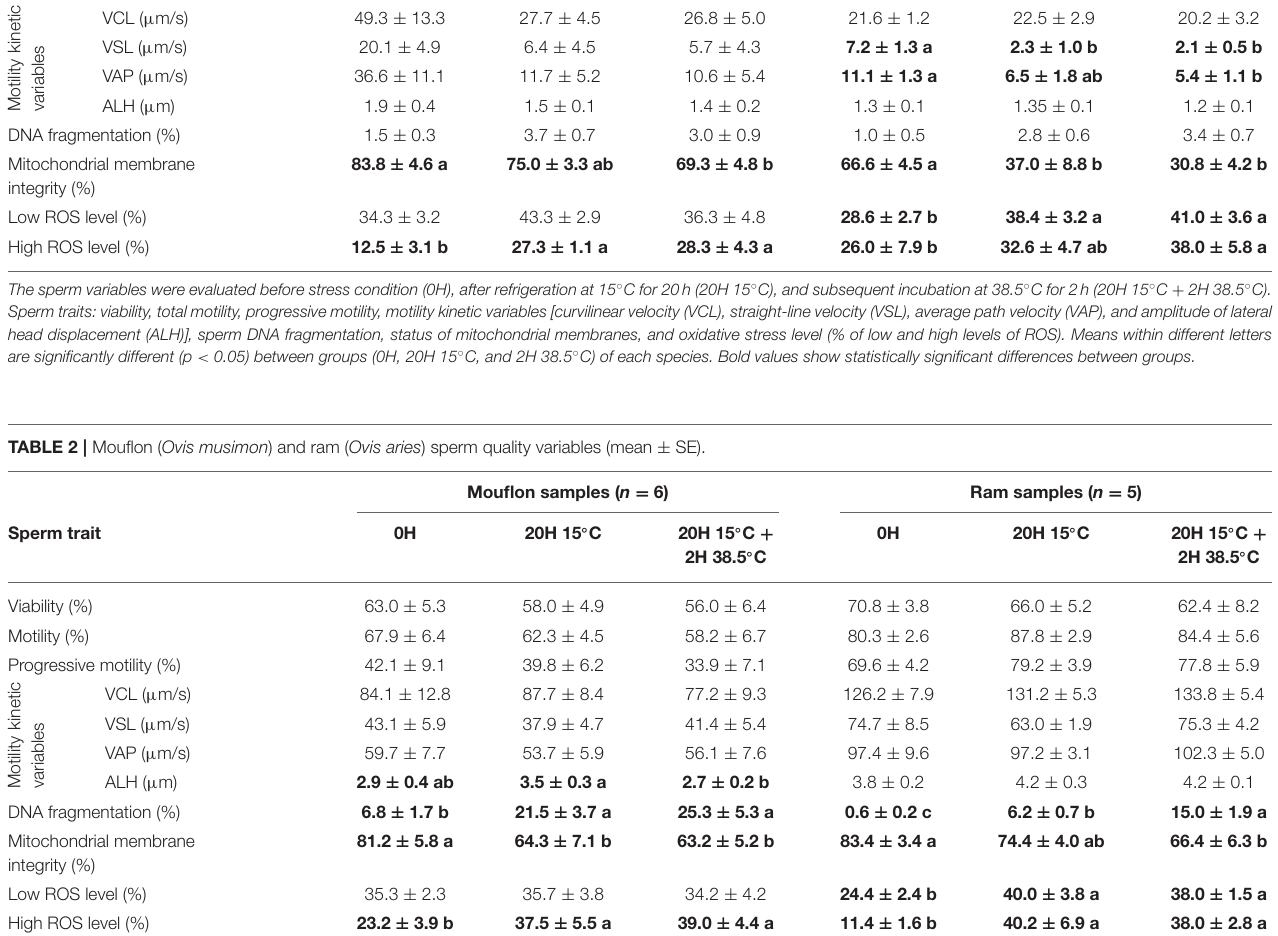
membrane integrity was lower ( p < 0.05) in domestic than in wild boar ( Figure 1 ). The SR for ROS production was higher in ram ( p < 0.05) than in mouflon ( Figure 2 ). In buck, the SR for VCL showed lower values ( p < 0.05) than in Iberian Ibex ( Figure 3